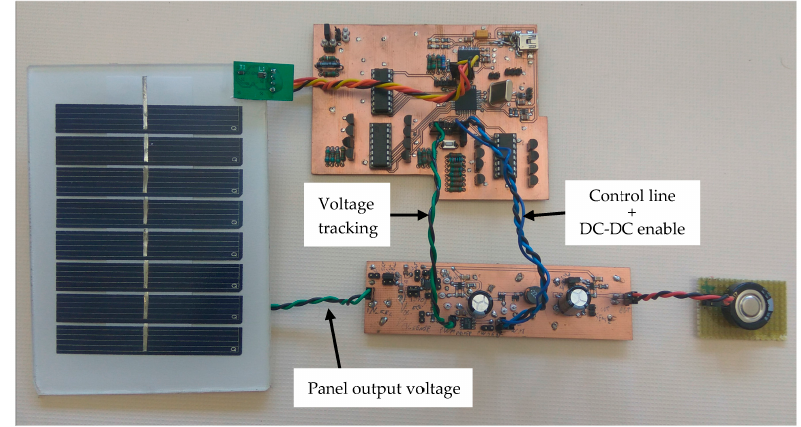
Figure 16. Full solar energy harvesting system based on ANN MPPT and energy storage system (supercapacitor): solar panel (left), control system (centre, on top, includes the characterization system), DC-DC system (centre, bottom) and supercap (right). In this case, only one of the 1.5 F supercaps is connected to the boost system for characterization purposes.